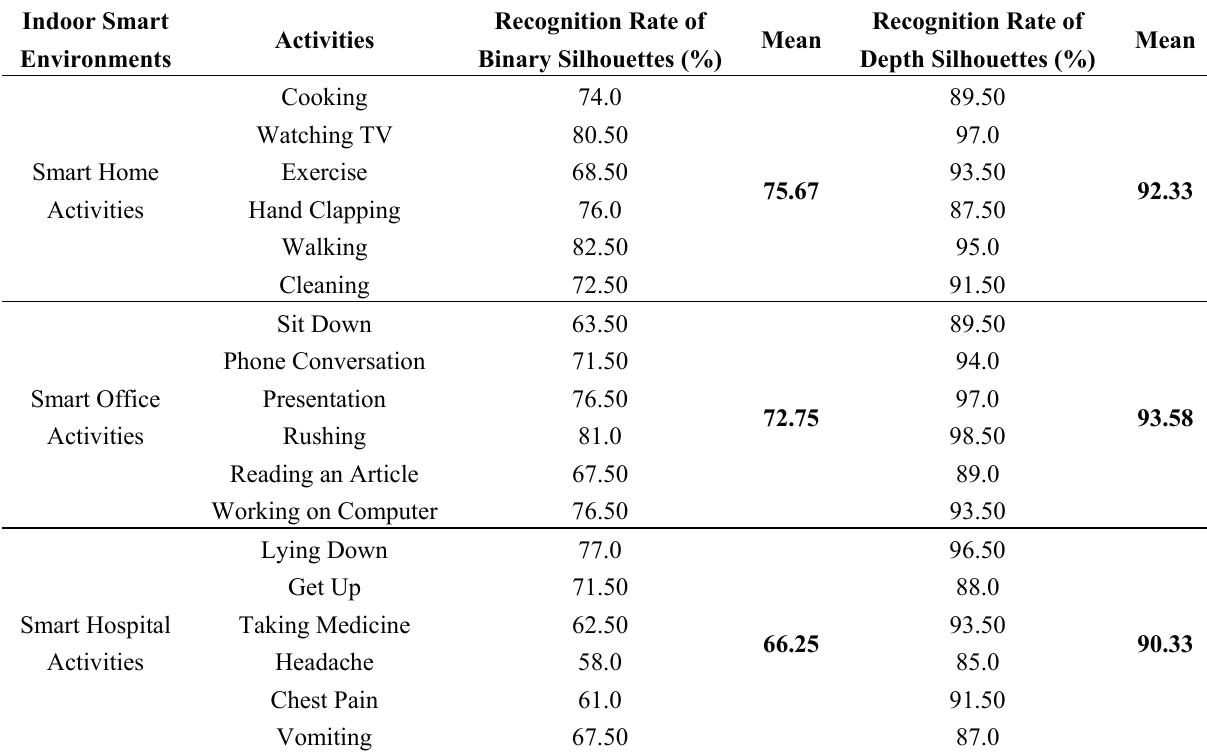
Table 2. Recognition results based on the proposed motion features using both binary and depth